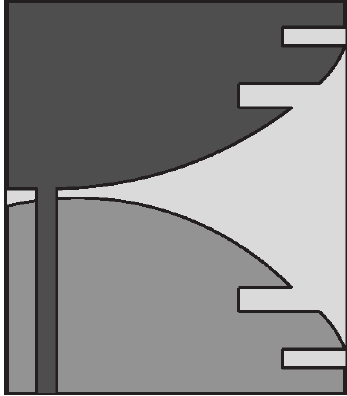
Figure 20. Design layout of a compact corrugated planar antenna (redrawn from [84]). Dark gray top metal face, medium gray bottom metal face, and light gray dielectric substrate.